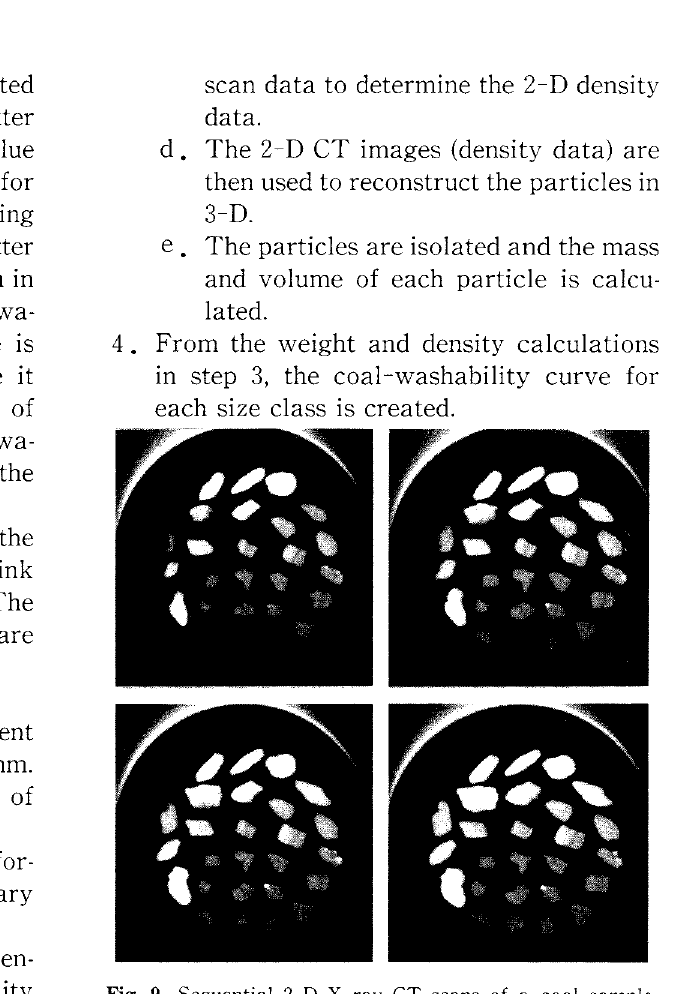
Fig. 9 Sequential 2-D X -ray CT scans of a coal sample. The grey-shaded bar at the right-hand side of the photograph represents the density scale in terms of CT